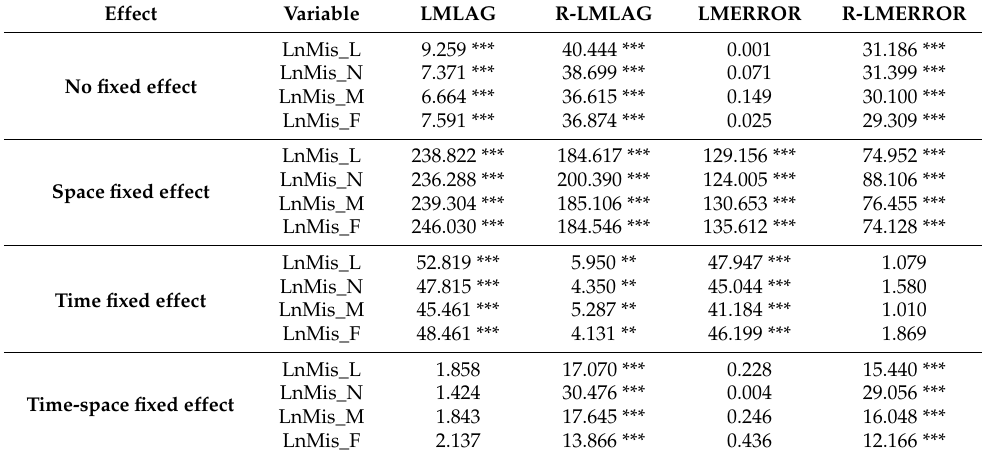
Table 6. Spatial diagnostic test results.